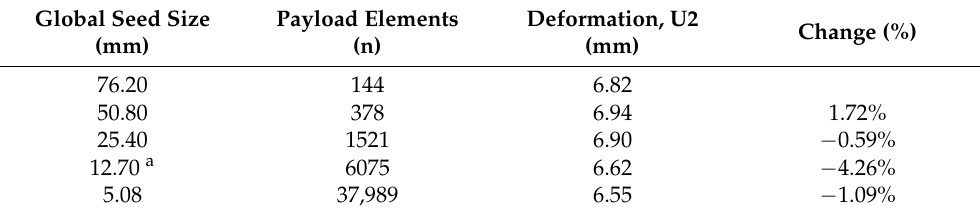
Figure 5. Payload mesh convergence results for 3 columns, 3 layers unit load. Maximum pallet deflection (U2, mm) at the board midspan versus total number of elements. Table 5. Payload mesh convergence study results for 3 columns, 3 layers unit load.